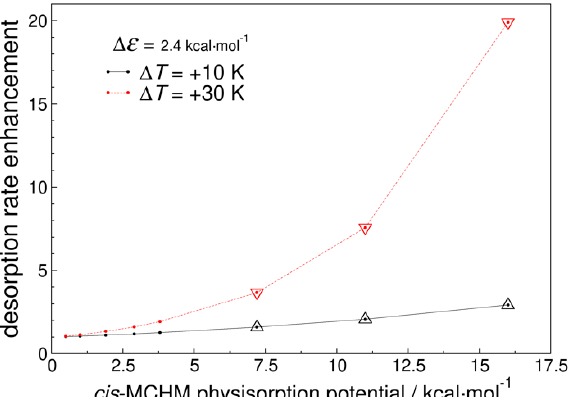
Figure 3. Enhancement in the predicted total desorption rate for MCHM from amorphous carbon as a function of hypothetical cis -MCHM physisorption potentials for temperature increases of 10 and 30 K. Enhancement is relative to the rate at 273 K. Results are plotted for the case where the difference in physisorption potentials for cis - and trans -MCHM is 2.4 kcal mol − 1 ; the trend is similar for any value of ∆ ε . The triangles highlight relevant values predicted by the molecular mechanics and semi-empirical predictions detailed in the text.